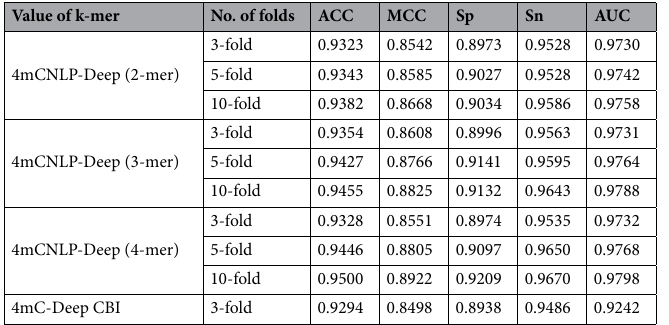
Table 3. The performance evaluation of 4mCNLP-Deep and state-of-the-art are demonstrated in Fig. 2.